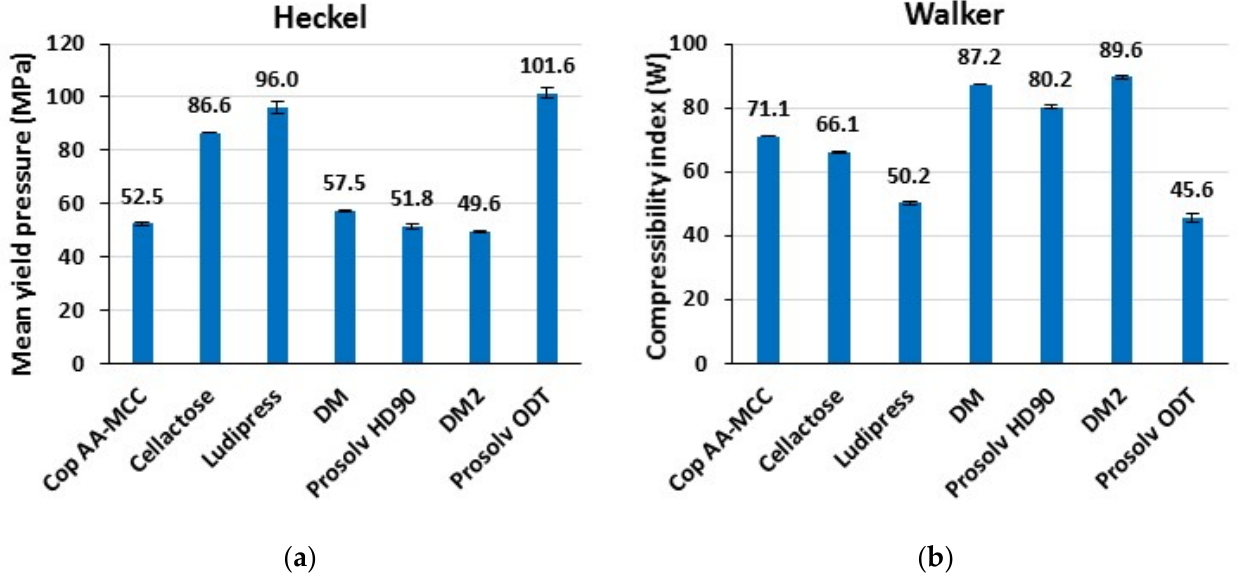
Figure 4. (a) Heckel and ( b ) Walker modeling for powder